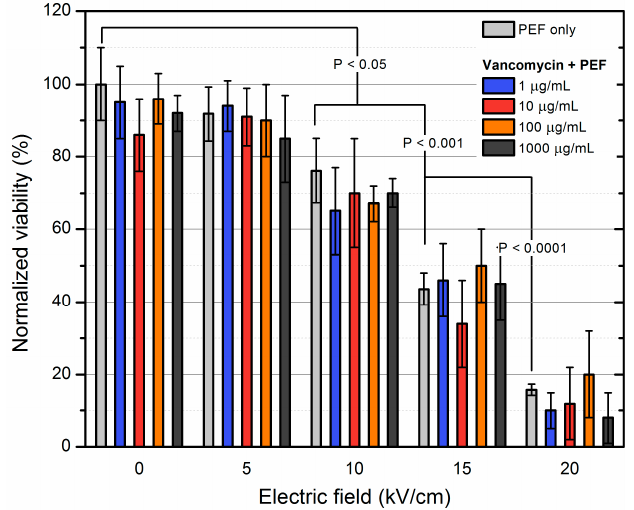
Figure 1. Inactivation of MRSA using electroporation separately and in combination with vancomycin of varied concentration. The 10 kV/cm PEF amplitude was the threshold value to induce inactivation of MRSA, however no additive effect with antibiotic was detected.